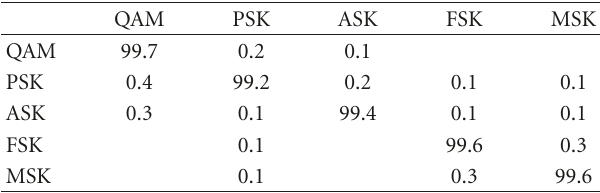
Table 7: Confusion Matrix at SNR = 2d B.